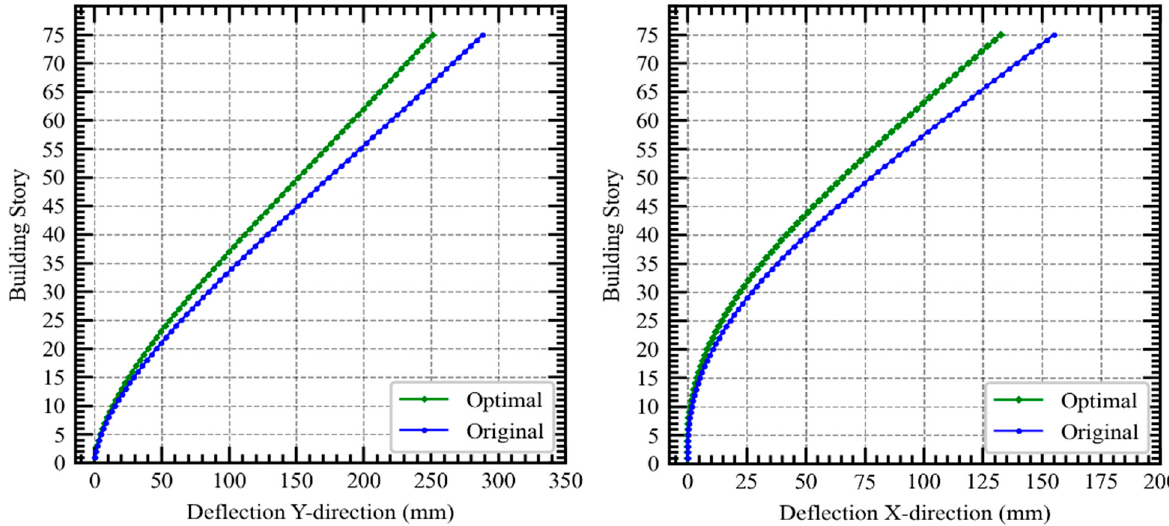
Figure 20. Maximum top structural deflection.